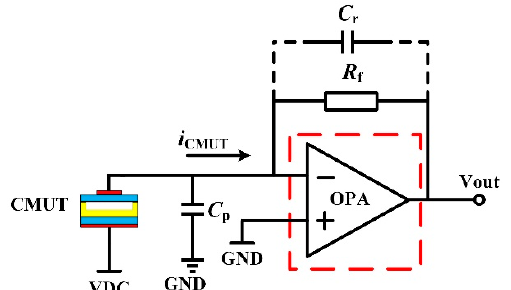
Figure 2. Schematic of the front-end receiver circuit with the CMUT and the red dotted frame is the proposed target amplifier of this design.